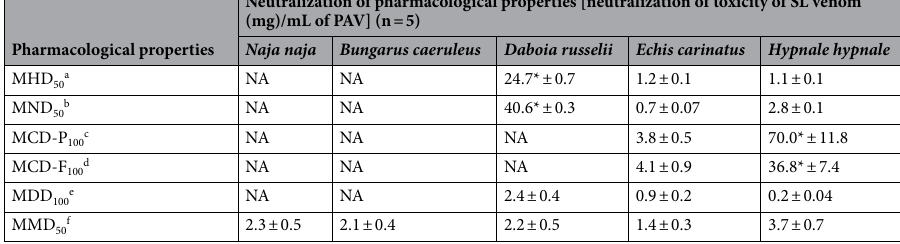
Table 3. Neutralization of in vivo pharmacological activities of SL snake venoms by newly developed SL PAV. Values are means ± SD of five values. *Significance of difference of neutralizaton potency between D. russelii, E. carinatus and H. hypnale (p < 0.05). The PAV was dissolved in 10 mL of sterilized water. Neutralization of pharmacological activity is expressed as activity of venom (mg) neutralized per mL of reconstituted PAV in water. NA indicates no activity by the venom. a Minimum hemorrhagic dose (MHD) is defined as the amount of venom (in μg dry weight) which, when injected intradermally, induces in mice a 10 mm hemorrhagic lesion after a predefined time interval, usually 2–3 h, post injection. b Minimum necrotizing dose (MND) is defined as the smallest amount of venom (in μg dry weight) which, when injected intradermally into anaesthetized mice, results in a necrotic lesion of 5 mm diameter post 3 days of treatment. c The minimum coagulant dose on plasma (MCD-P) is defined as the smallest amount of venom (in mg dry weight per liter of test solution or μg/mL) that induces clotting of citrated human plasma under the experimental conditions. d The minimum coagulant dose on fibrinogen (MCD-F) is defined as the smallest amount of venom (in mg dry weight per liter of test solution or μg/mL) that clots a solution of bovine fibrinogen in 60 s at 37 °C. e Minimum defibrinogenating dose (MDD) is defined as the minimum dose of venom that produces incoagulable blood in all mice within 1 h of intravenous injection. f Mimimum myotoxic dose (MDD) is characterized by the appearance of myoglobin in urine and by increments in the serum levels of muscle-derived enzymes, creatine kinase